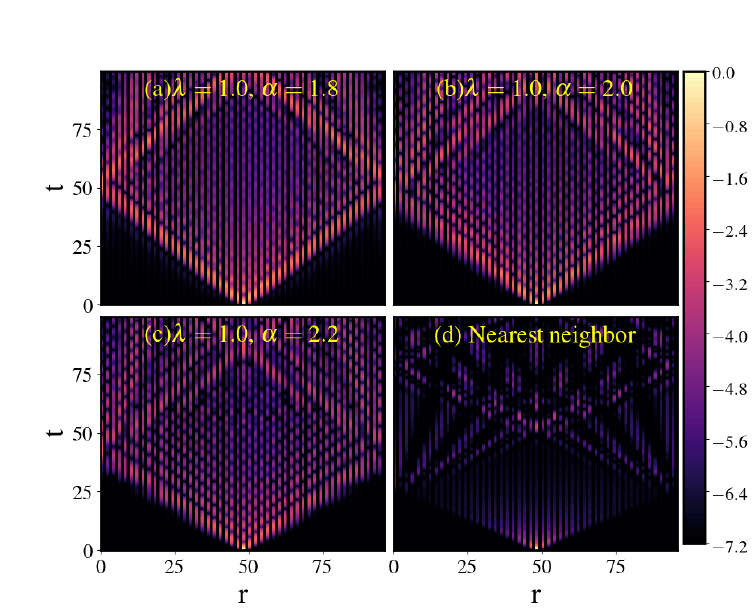
Figure 9: Same as Fig.8 but for the “magnon density” 〈 N ↑ ( r , t ) N ↑ ( r + 1, t ) N ↑ ( r + 2, t ) 〉